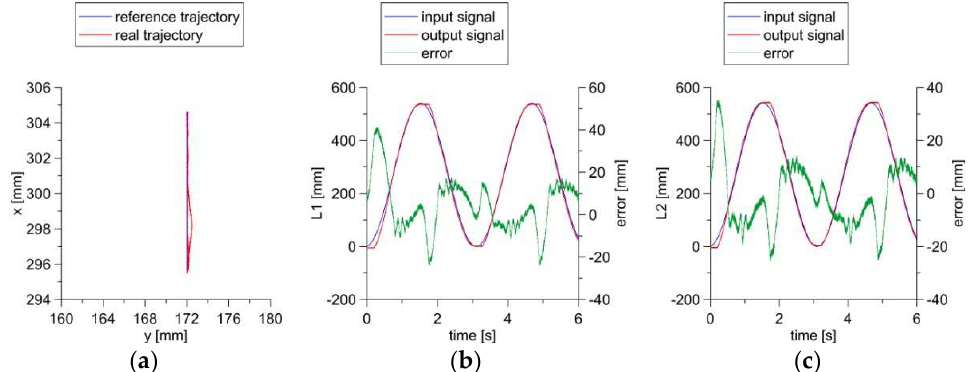
Figure 6. The positioning of the manipulator end effector along the y -axis: ( a ) end-effector trajectory, ( b ) displacement of the A1 actuator, ( c ) displacement of the A2 actuator.